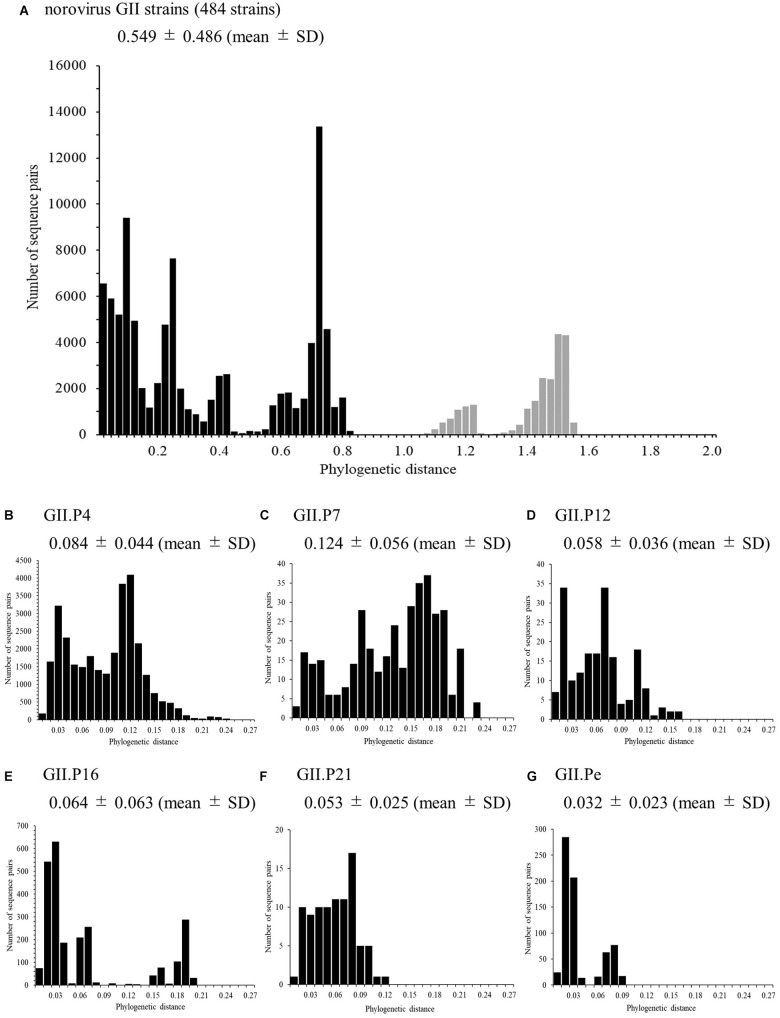
Phylogenetic distances between sequences of the full-length norovirus RdRp region. The distributions of phylogenetic distances of the norovirus GII strains (A), GII.P4 (B), GII.P7 (C), GII.P12 (D), GII.P16 (E), GII.P21 (F), and GII.Pe (G) are shown. The y-axis represents the number of sequence pairs corresponding to each distance, and the x-axis shows the phylogenetic distance. The distribution of phylogenetic distance for ≥1.0 is shown in gray in (A). The numbers on the histograms indicate the mean ± SD of all phylogenetic distances for GII strains (A) and each genotype (B–G). The statistical results for multiple comparisons are shown in Supplementary Table S3.